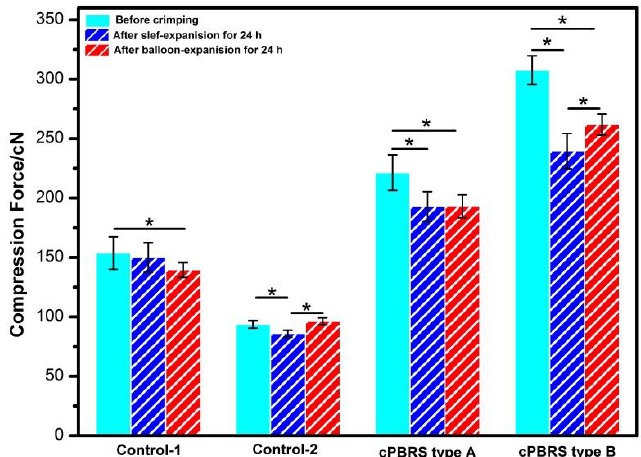
Figure 5. Compression force changes of different prototypes during crimping and expanding process. (* means p < 0.05)